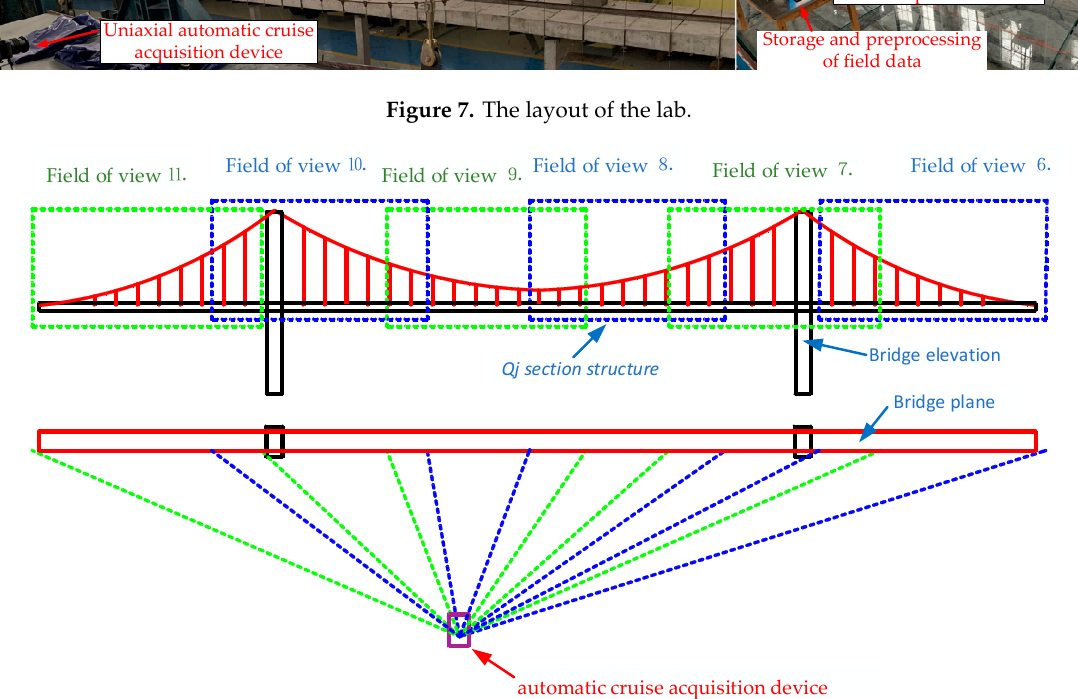
Figure 8. The principle of image collection.